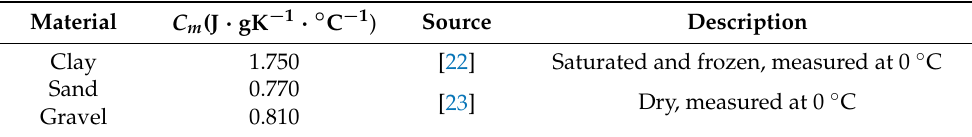
Table 2. Values of 𝐶 (cid:3040) from the literature.